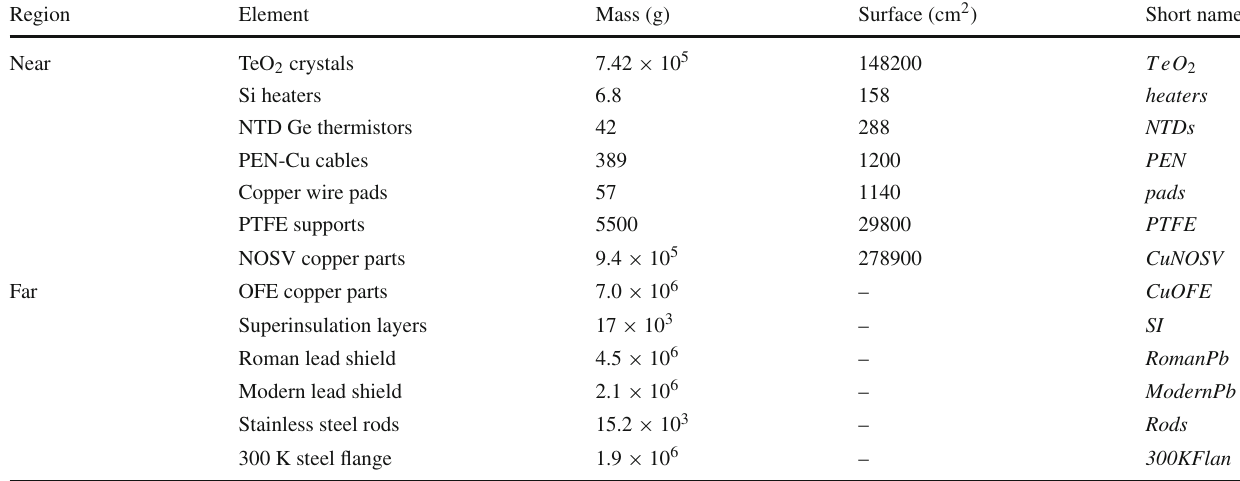
close to the TeO 2 detectors. Surface contamination is simulated only for elements in the near region, hence surface areas are listed only for them. The surface area indicated for NOSV copper parts only takes into account surfaces directly facing the detectors. The rightmost column lists the short name of the components used in this